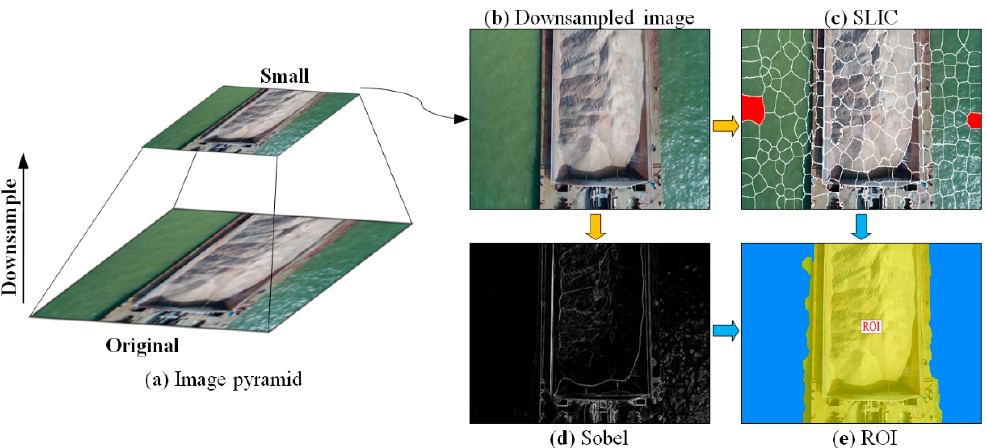
Figure 8. Validation of overlap for stereo image extraction. 3.2. ROI-based Photogrammetry Typically, UAV-based image acquisition from low-cost UAVs (e.g., DJI quadcopters) has large perspective distortions and poor sensor geometry [20,32], i.e., systematic errors, which need to be eliminated in terms of sensor parameters (Table 2). The ROI of the barges and the stockpiles is defined to exclude the area of water in all UAV images and suit the volume measurement of the stockpiles carried on barges, thereby improving the accuracy of image matching and accelerating photogrammetry. In accordance with the clear gap of image color, intensity, and texture between barge and water, image segmentation is used to classify water and non-water regions. Moreover, effective and efficient segmentation is achieved by